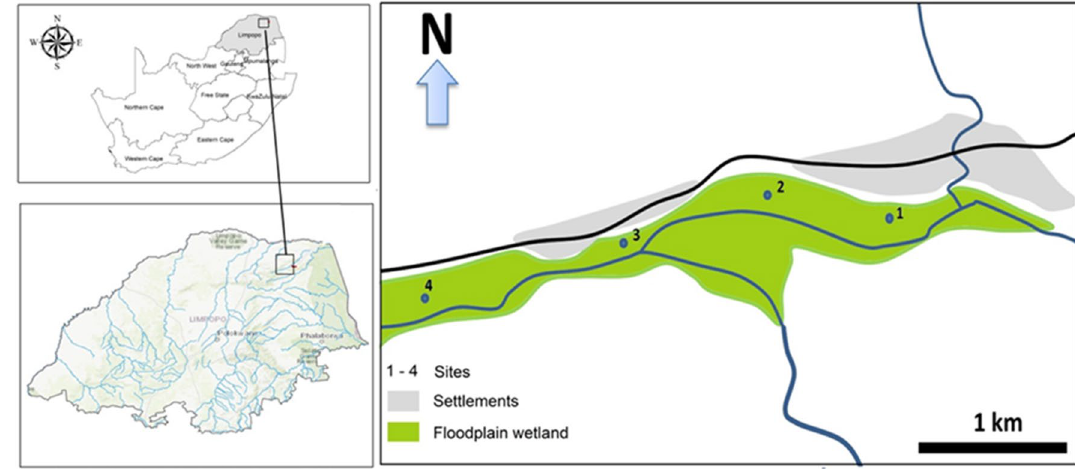
Fig. 1 Map highlighting the location Sambandou wetland and the selected study